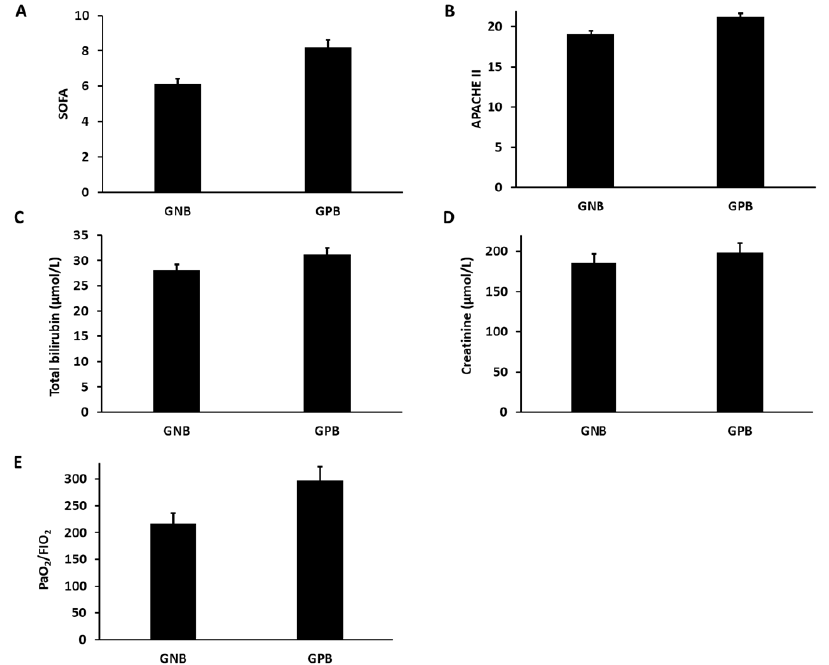
Figure 4. ( A ) Bar diagrams representing the SOFA score in the GPB and GNB groups ( B ) Bar dia- grams representing the APACHE II score in the GPB and GNB groups ( C ) Bar diagrams represent- ing the total bilirubin content in the GPB and GNB groups groups. ( D ) Bar diagrams representing the creatinine in the S. aureus and E. coli . ( E ) Bar diagrams representing the PaO 2 / FIO 2 ratio in the GPB and GNB groups.